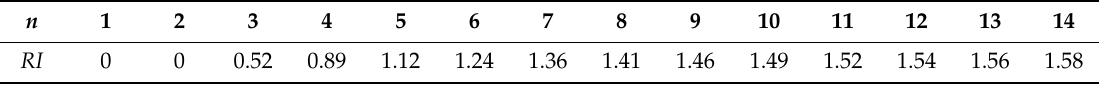
Table 1. Random consistency index